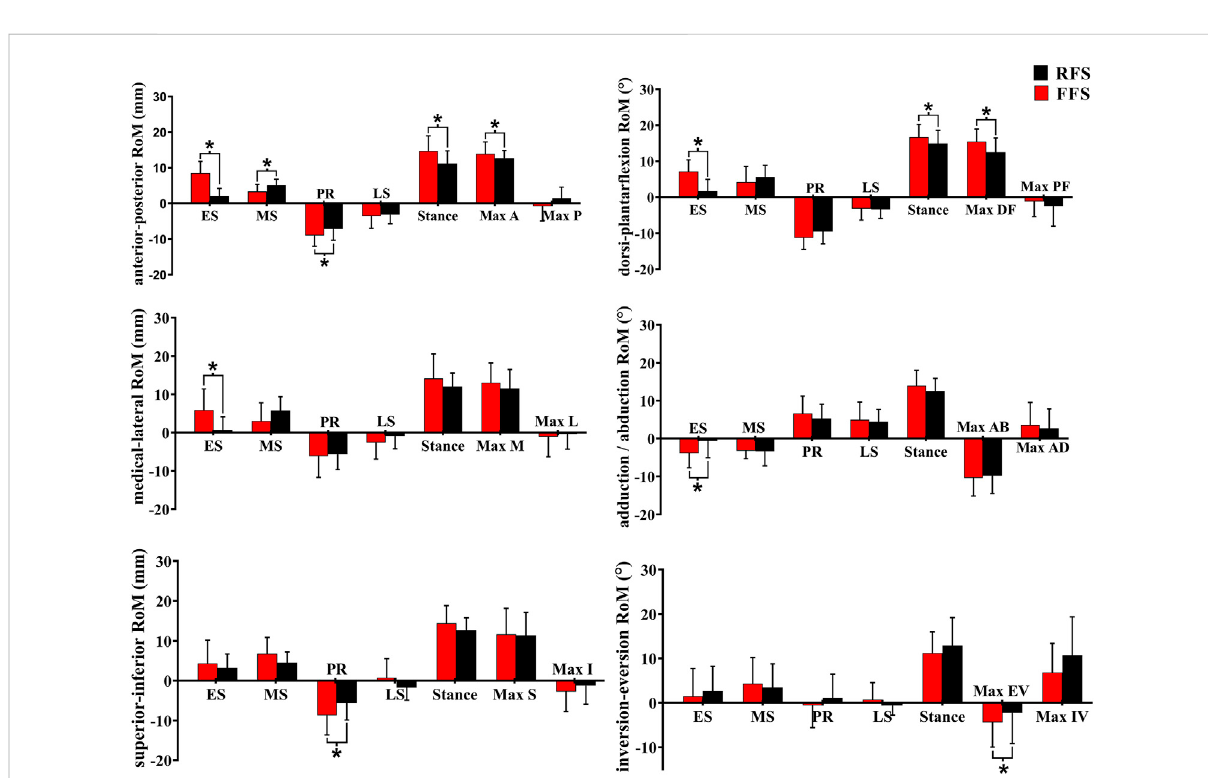
FIGURE 8 Effects of different foot strike patterns on the range of motion of MLA and characteristic values during the stance phase of running. Note: RFS, rearfoot strike pattern and FFS, forefoot strike pattern; ES, early stance phase; MS, mid-stance phase; PR, propulsion phase; LS, late stance phase; stance, entire stance phase; A, anterior translation; P, posterior translation; DF, dorsi fl exion; PF, plantar fl exion; M, medial translation; L, lateral translation; AD, adduction; AB, abduction; S, superior translation; I, inferior translation; EV, eversion; IV, inversion. * signi fi cant difference between FFS and RFS during running, p < 0.05.